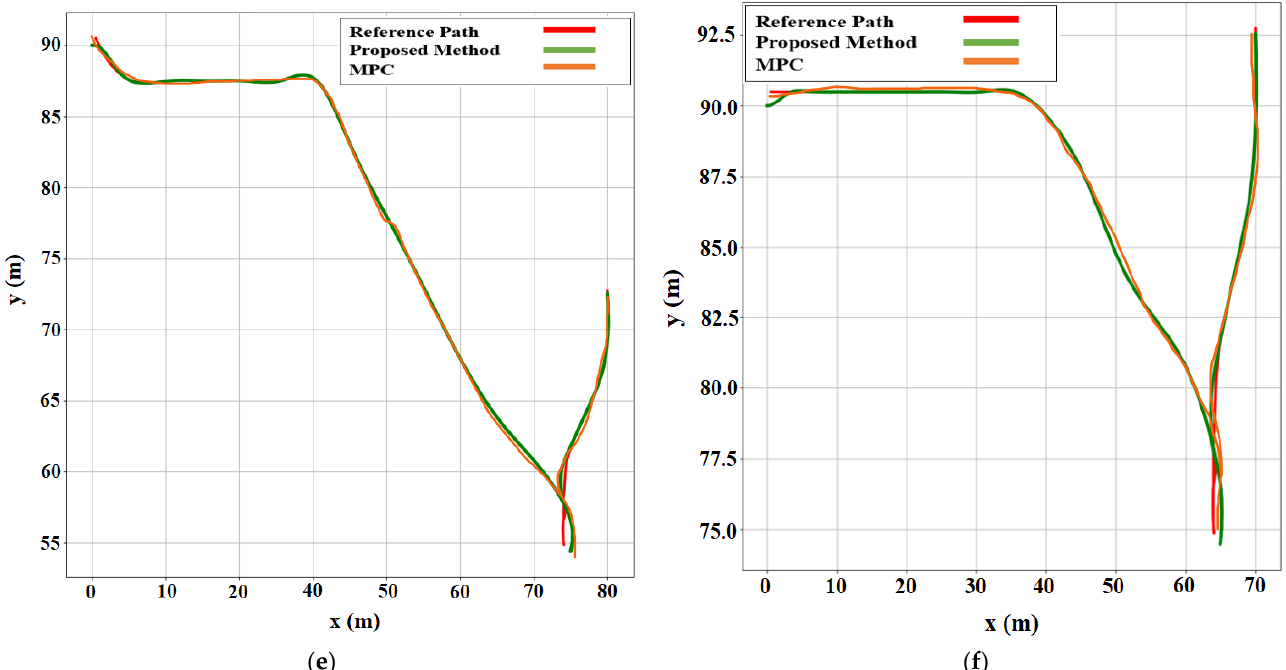
Figure 8. Comparison of path-following techniques with respect to the reference path. For each case, the MPC method was compared with the proposed method. ( a ) Case 1. ( b ) Case 2. ( c ) Case 3. ( d ) Case 4. ( e ) Case 5. ( f ) Case 6.